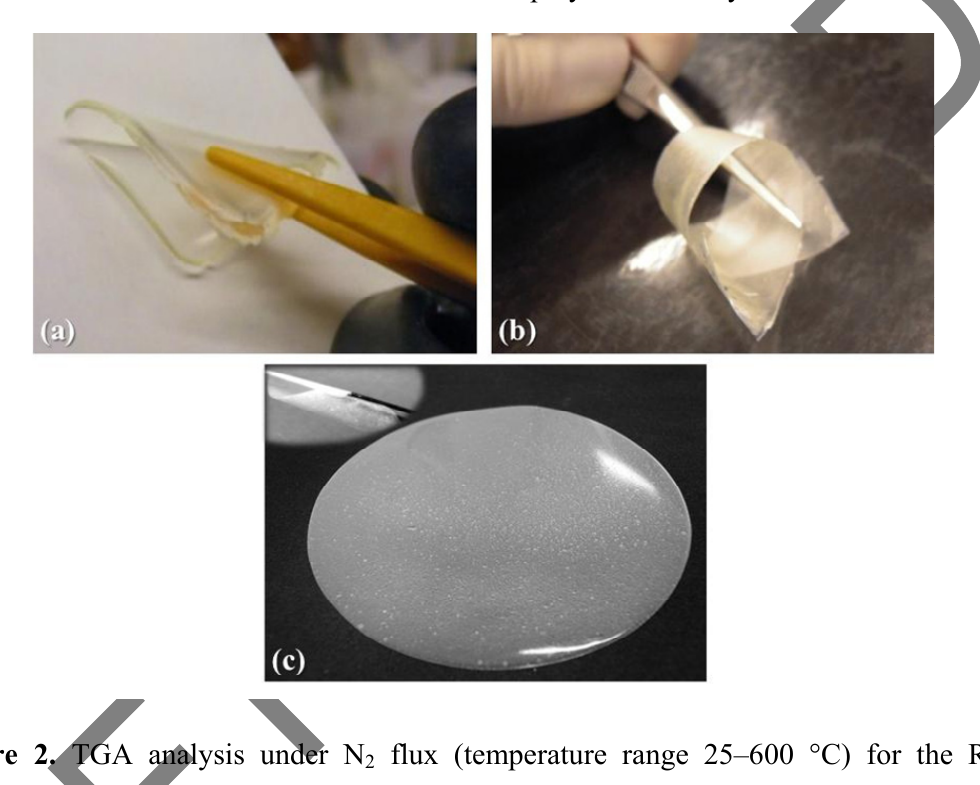
flux (temperature range 25–600 °C) for the RC-1 2